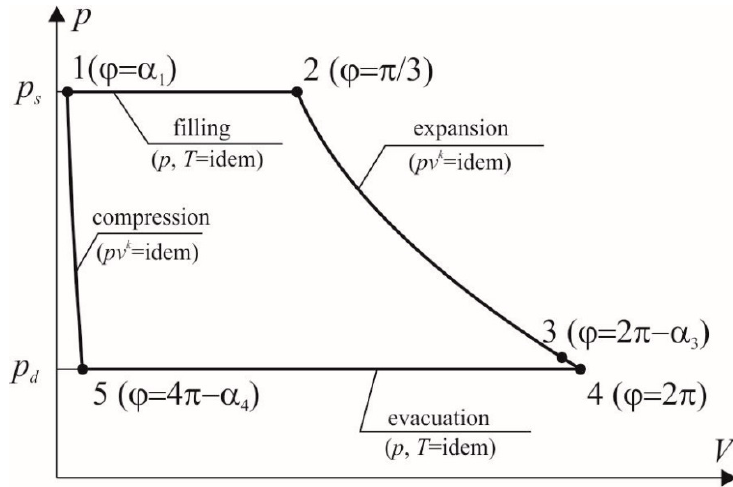
Figure 4. The rolling piston expander thermodynamic cycle in the p - V plane.